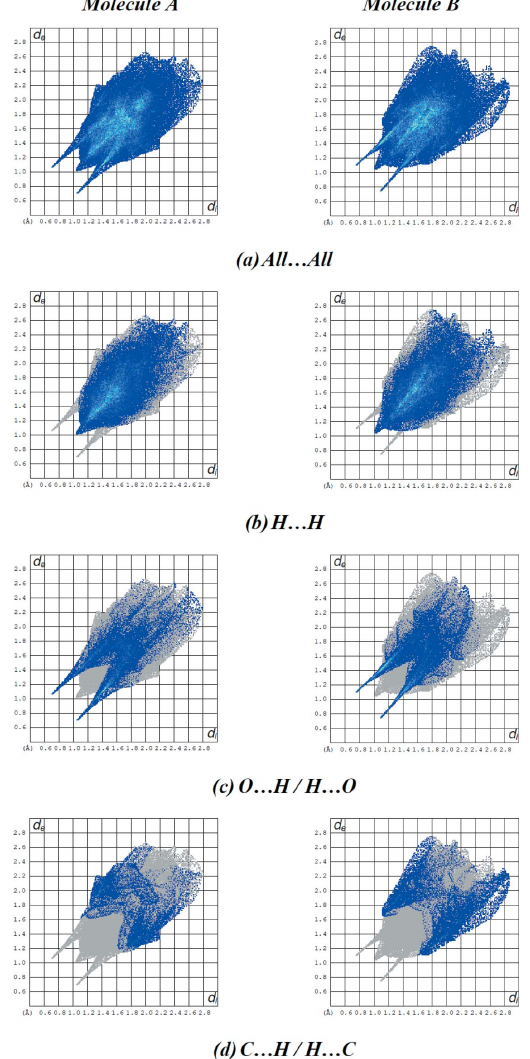
Figure 6 The two-dimensional fingerprint plots for molecules A and B of the title compound 3 showing ( a ) all interactions, and delineated into ( b ) H (cid:3)(cid:3)(cid:3) H, ( c ) O (cid:3)(cid:3)(cid:3) H/H (cid:3)(cid:3)(cid:3) O and ( d ) C (cid:3)(cid:3)(cid:3) H/H (cid:3)(cid:3)(cid:3) C interactions. The d i and d e values are the closest internal and external distances (in A ˚ ) from given points on the Hirshfeld